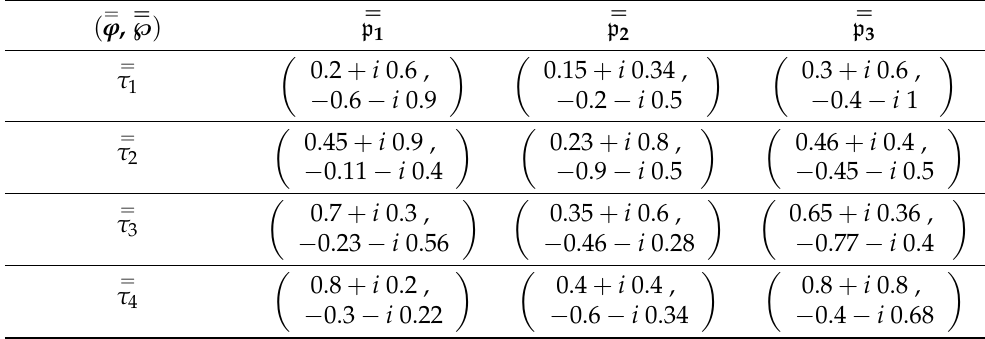
Table 2. The tabular representation of BCFSS described in example